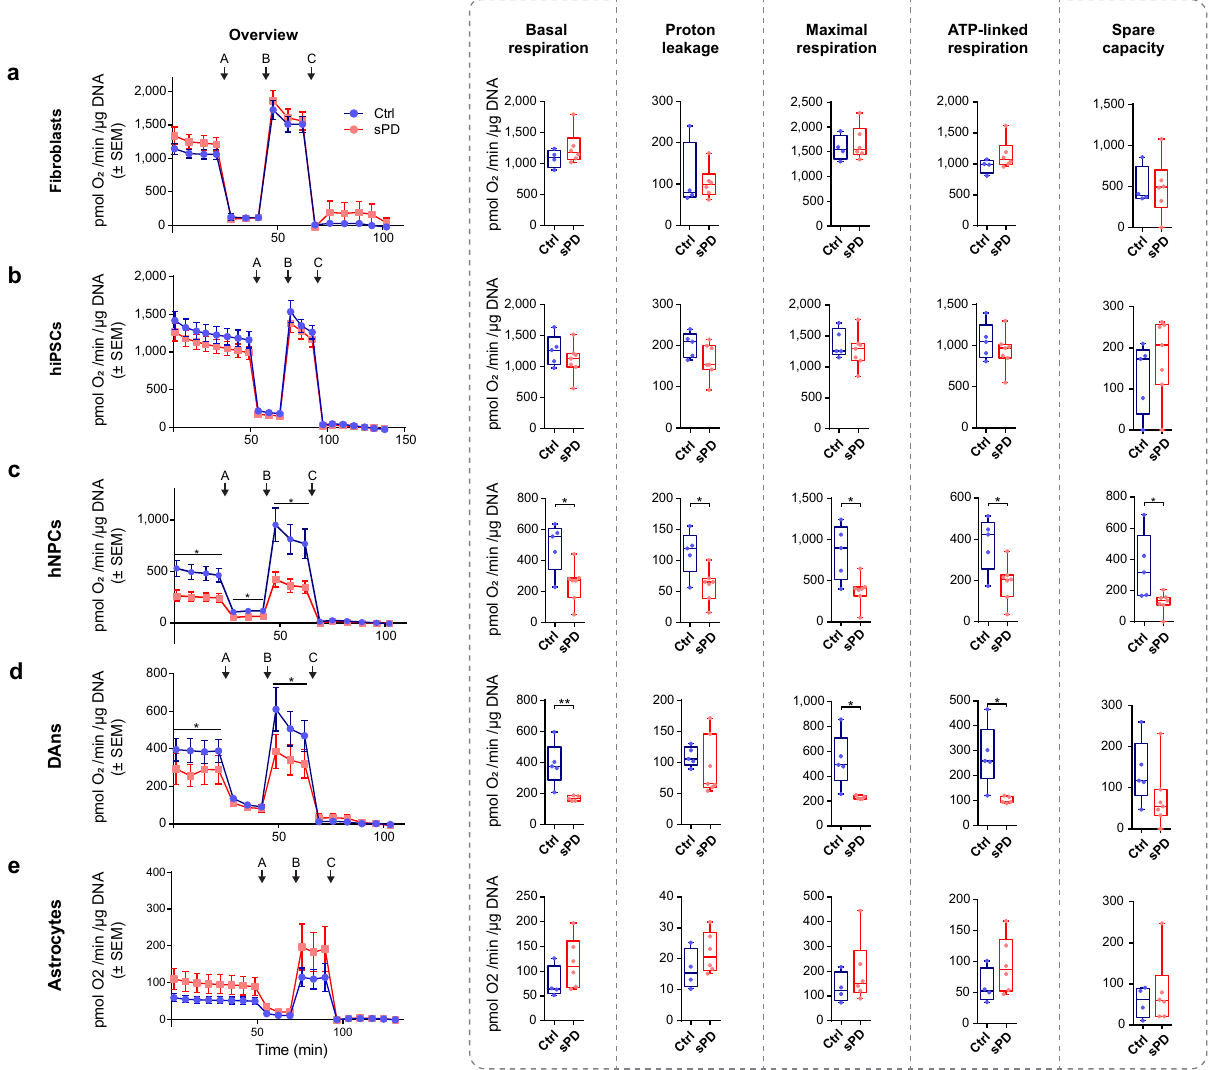
Fig.2|MitochondrialdysfunctiondevelopsinsPD upondopaminergicneuron differentiation.a Mitochondrialstresstestperformedin fi broblastsderivedfrom n =4 Ctrl and 7 sPD patients (in triplicates), (b) hiPSCs, (c) hNPCs, (d) DAns derived from 5 Ctrl and 7 sPD patients (in triplicates), or (e) astrocytes derived from4Ctrland6sPDpatients(intriplicates)usingaSeahorseXFe96Extracellular Flux Analyzer. Injected were (A) Oligomycin (1 µ g/ml), (B) FCCP (0.5 µ M), and (C) Rotenone (5 µ M)/Antimycin A (2 µ M). Measurement progression is shown with means±standard error of the mean (SEM). Boxplots display means of serial measurementsforbasalandmaximalrespiration(max),protonleakageaswellas the difference between basal respiration and proton leak for ATP linked respiration (ATPl) and the difference between basal and maximal respiration for